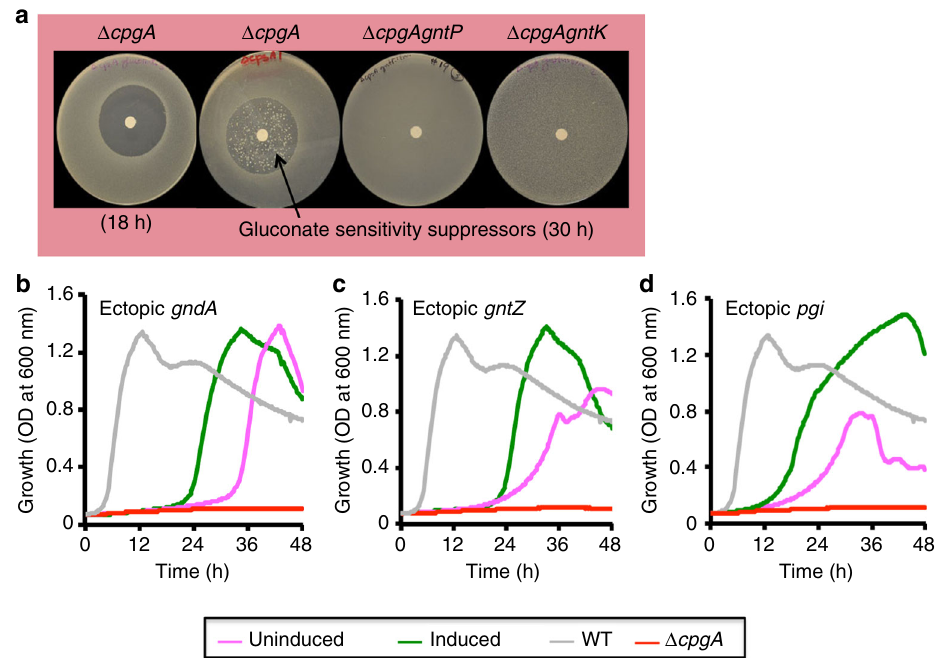
Fig. 4 Intoxication of Δ cpgA cells by 6PG, a potent inhibitor of PGI. a Images of disk diffusion assays performed in MH media with ~20 μ mols gluconate for various strains. Arrow indicate colony formation within the zone of clearance, indicative of suppressor mutations, as seen for Δ cpgA upon extended incubation (30 h). Gluconate resistance is observed for the Δ cpgA gntP and Δ cpgA gntK strains. Growth curves are shown for WT (gray line), Δ cpgA (red line), and Δ cpgA containing ectopic constructs at amyE locus for b gndA c gntZ and d pgi . Ectopic strain constructs were tested with ( gndA induced with 250 nM, gntZ with 0.5 mM, and pgi with 1 mM IPTG, green line) and without IPTG (pink line) in MSMM with 0.8% glucose. Aerobic growth was monitored every hour for the period of 48 h at 37 °C. The data set is representative of three or more independent biological